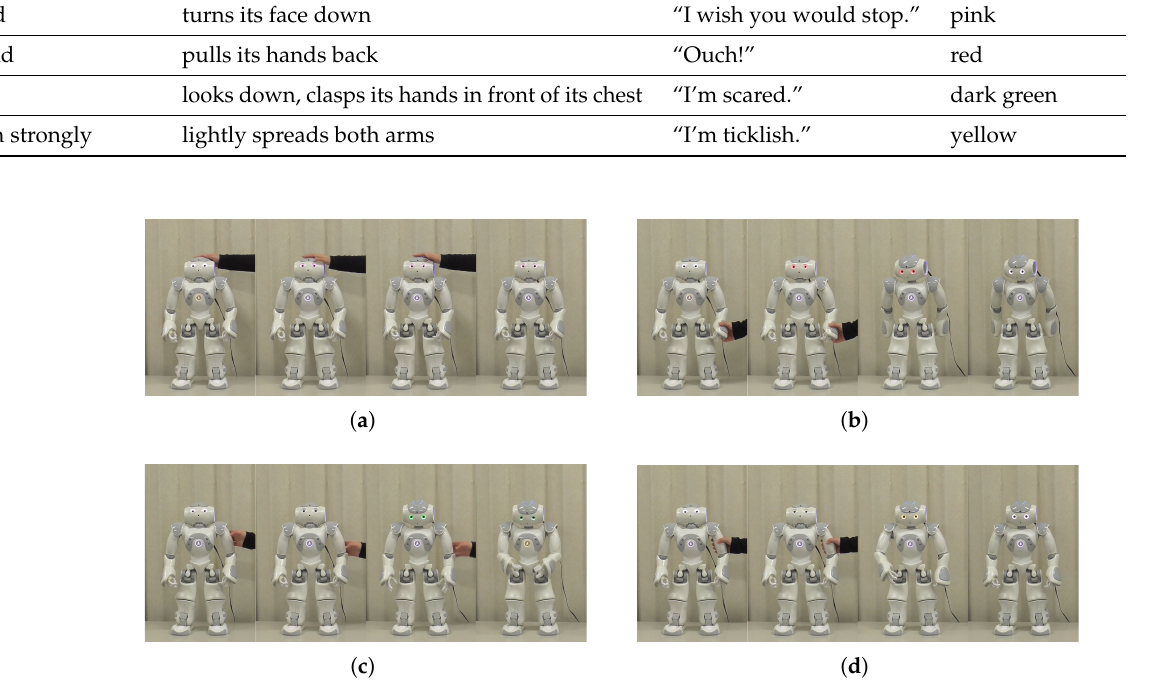
Figure 3. Frames from videos of contradictory reactions of NAO to human touch. ( a ) Case: stroking the head; ( b ) Case: touching the hand; ( c ) Case: stroking the arm; ( d ) Case: grabbing the arm